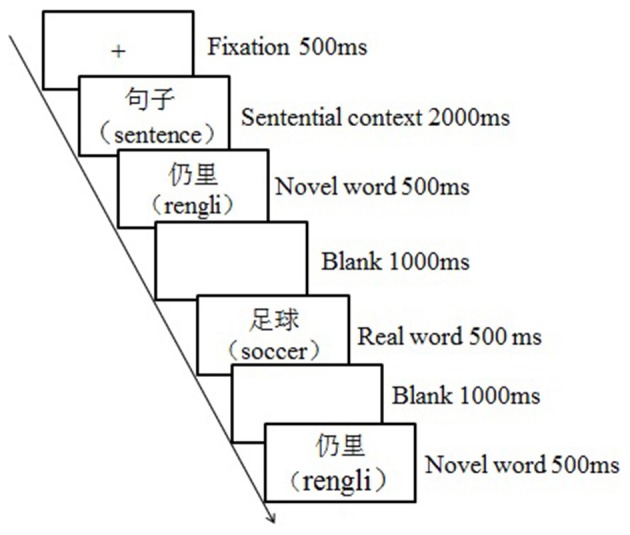
The illustration of learning trial.